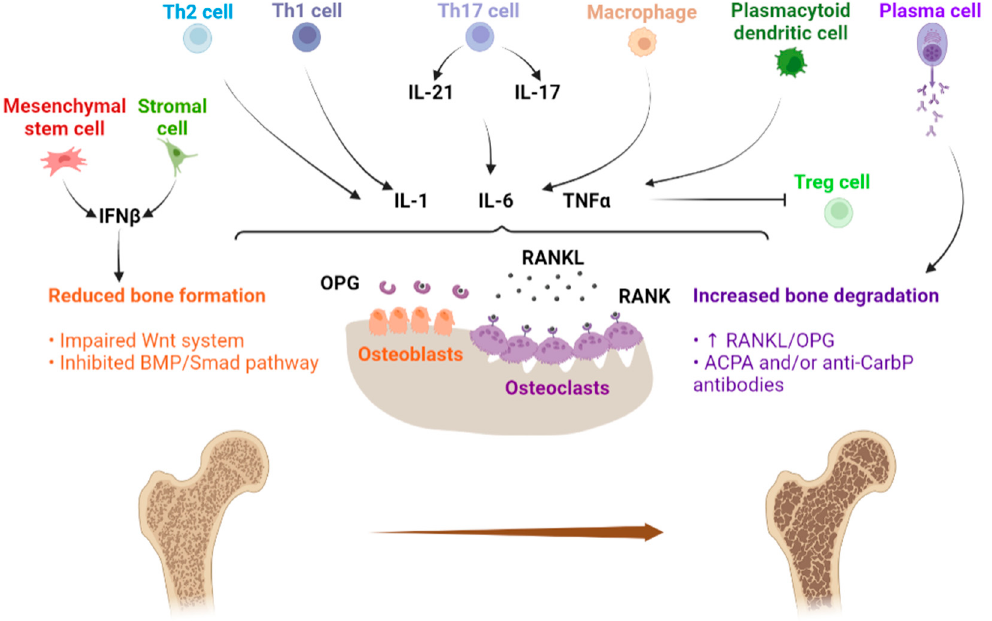
Figure 1. Osteoimmunology: the tight interplay between immune system and bone metabolism in SLE. Immune cells interplay affecting bone metabolism, mainly by means of a proinflammatory cytokine network that impairs the balance between osteoclast and osteoblast function. ACPA: anti- citrullinated protein antibody. Anti-CarbP: anti-carbamylated protein. BMP: bone morphogenetic protein. IFN β : interferon β . IL-1: interleukin 1. IL-6: interleukin 6. IL-17: interleukin 17. OPG: osteoprotegerin. RANK: receptor activator of nuclear factor-kB. RANKL: receptor activator of nuclear factor-kB ligand. SLE: systemic lupus erythematous. Smad: small mother against decapentaplegic. Th1 cells: T helper 1 cells. Th2 cells: T helper 2 cells. Th17 cells: T helper 17 cells. TNF α : tumor necrosis factor α . Treg cells: T regulatory cells. Wnt: wingless-related integration site. Original figure.